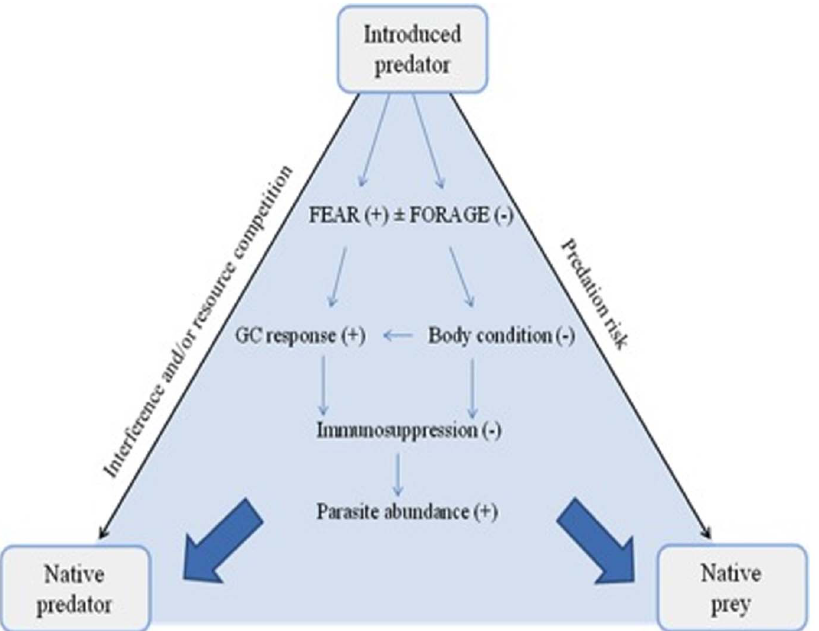
Figure 1. Stress triangle: Non-consumptive costs of introduced predators on native predators and prey, and the potential pathways of these costs. The ‘predator stress hypothesis’ predicts that fear will drive a chronic glucocorticoid (GC) response that leads to immunosuppression and consequent increases in parasite load. The ‘predator sensitive foraging hypothesis’ predicts that animals will reduce their foraging efficiency and hence lose body condition. This may lead directly to immunosuppression and an increase in parasite load, or indirectly by stimulating a GC response. These pathways can be set in train by an introduced predator via competition or the risk of predation on native predators and prey, respectively, forming the base of the triangle. Arrows show direction of pathway, with symbols representing an increase ( + ) or decrease ( 2 ) in an individual’s response.